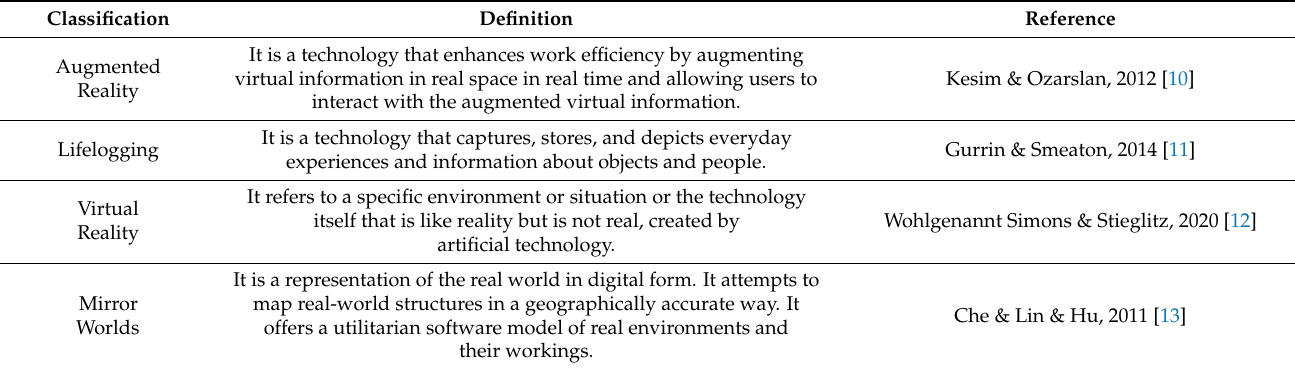
Table 1. The definitions of four metaverse